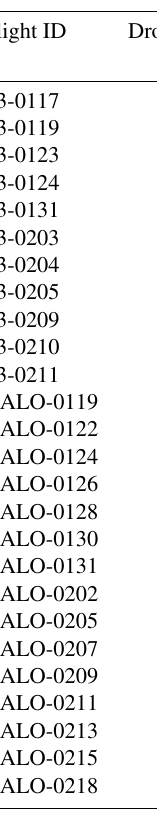
Table 2. Total number of dropsondes launched, circles flown during the flight, and takeoff and landing times (in UTC, dates in yyyy-mm- dd) for the flight are provided with corresponding flight IDs. Numbers in parentheses in the second column indicate the number of good dropsondes per flight (explained in Sect. 3). Note that the table only shows circles with dropsonde launches. There were also circles flown with no dropsonde launches during EUREC 4